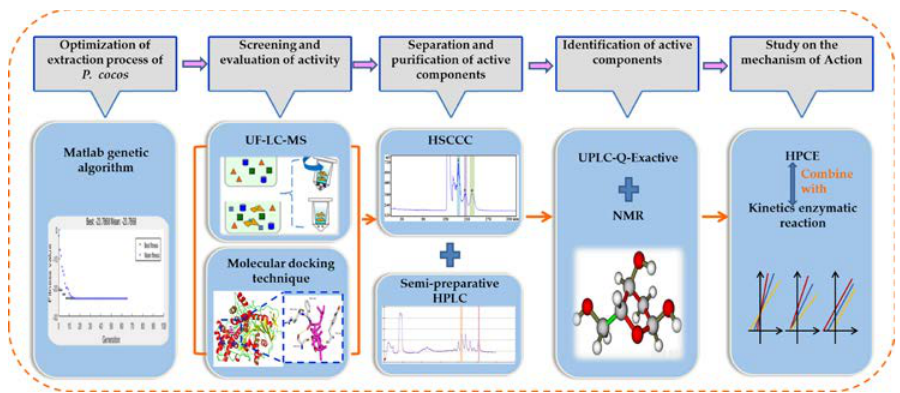
Figure 1. Schematic illustration of the workflow for exploring the activity screening, isolation of acetylcholinesterase inhibitors (AChEIs), and the in vitro inhibiting effect of Poria cocos ( P. cocos ).